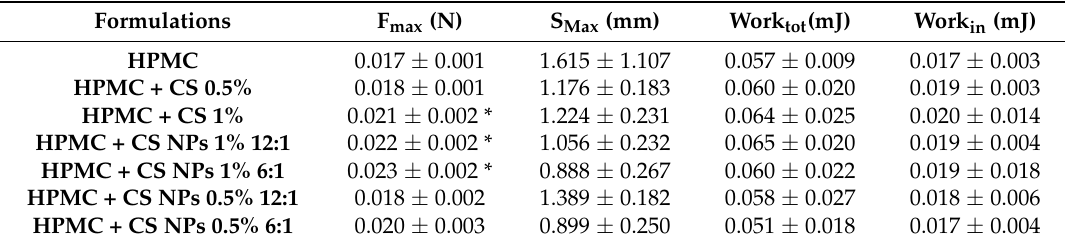
Table 1. Mucoadhesiveness parameters (F max ; S max ; Work tot , Work in ) calculated from the in vitro mucoadhesiveness test performed on the prepared HPMC 5.5% ( w / w ) hydrogels in presence of 0.5% ( w / w ) and 1% ( w / w ) chitosan, both as free polymer and as nanoparticles. The reported values are the mean ± SD of five replicates.